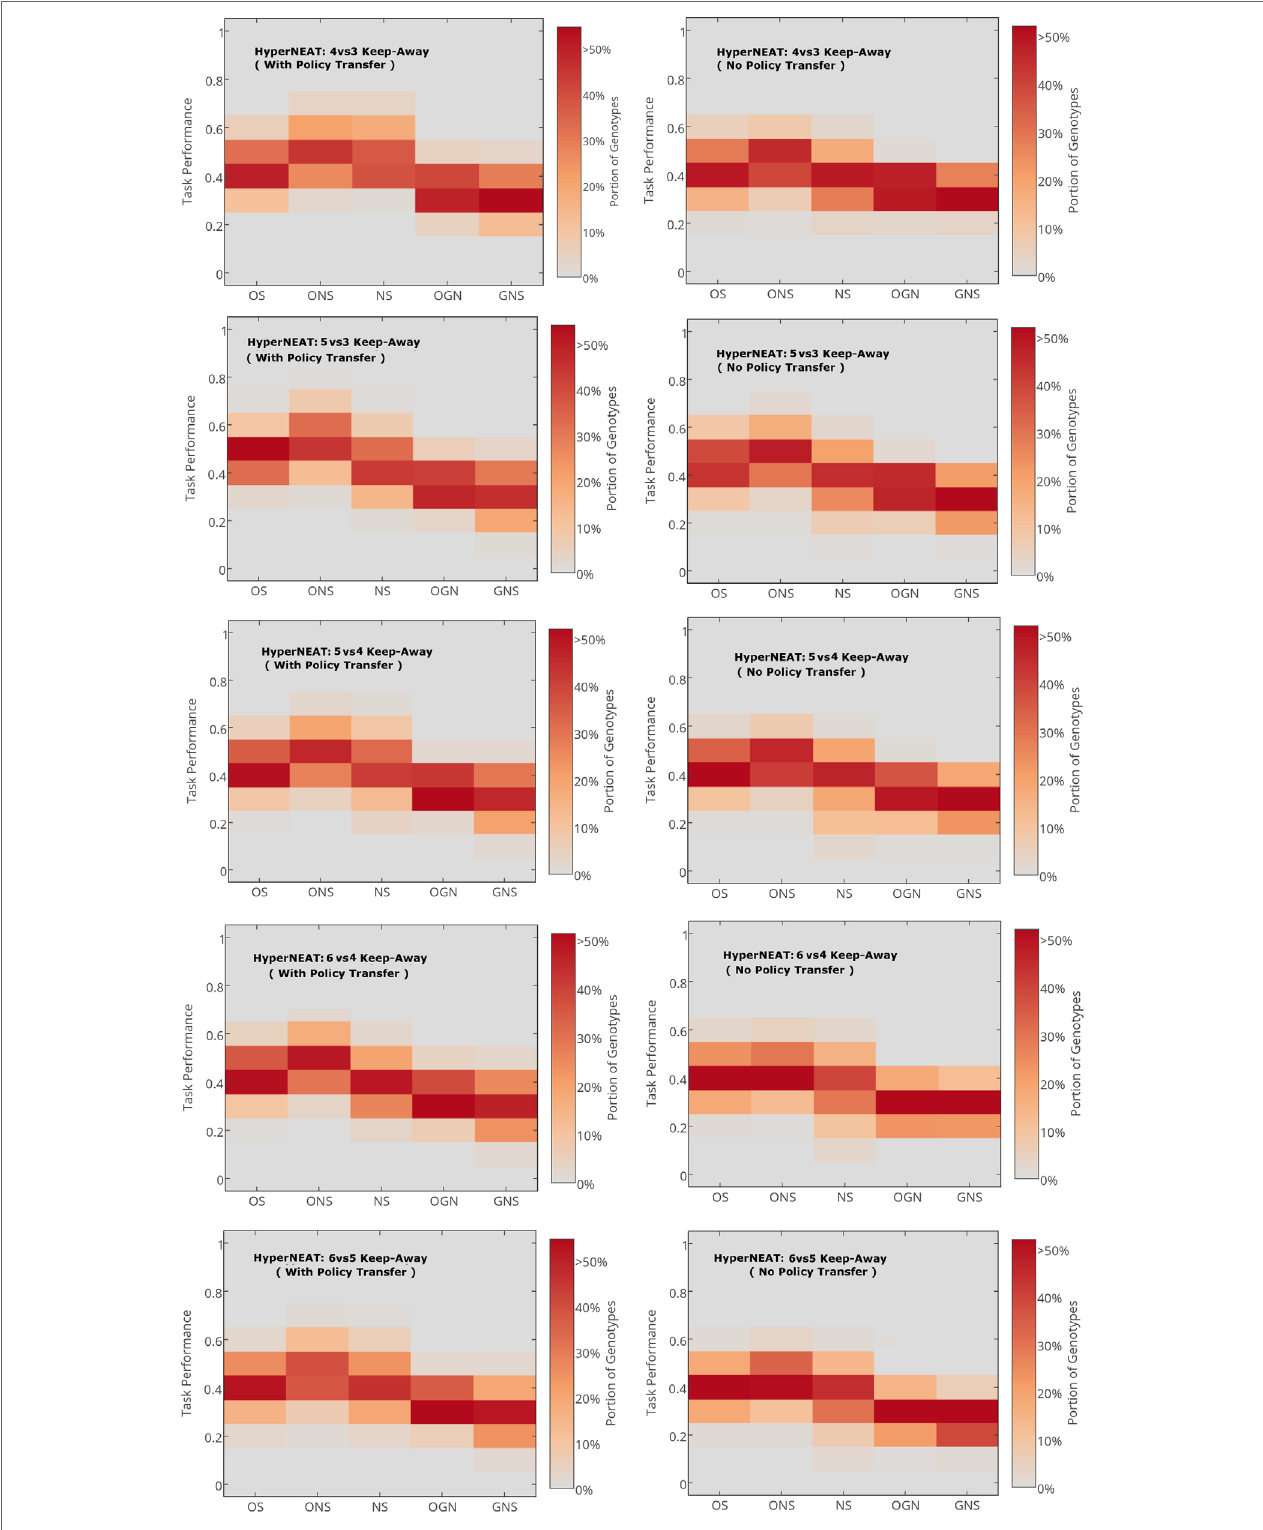
FigUre 3 | Heat-maps showing portions of (final generation) genotypes evolved by HyperNEAT variants with (left column) and without (right column) policy transfer. OS, objective-based; NS, novelty search; ONS, objective-novelty hybrid; GNS, genotypic novelty search; OGN, objective-GNS hybrid. Darker shading indicates a higher portion of genotypes in a given 0.2 interval of normalized task performance [0.0, 1.0].